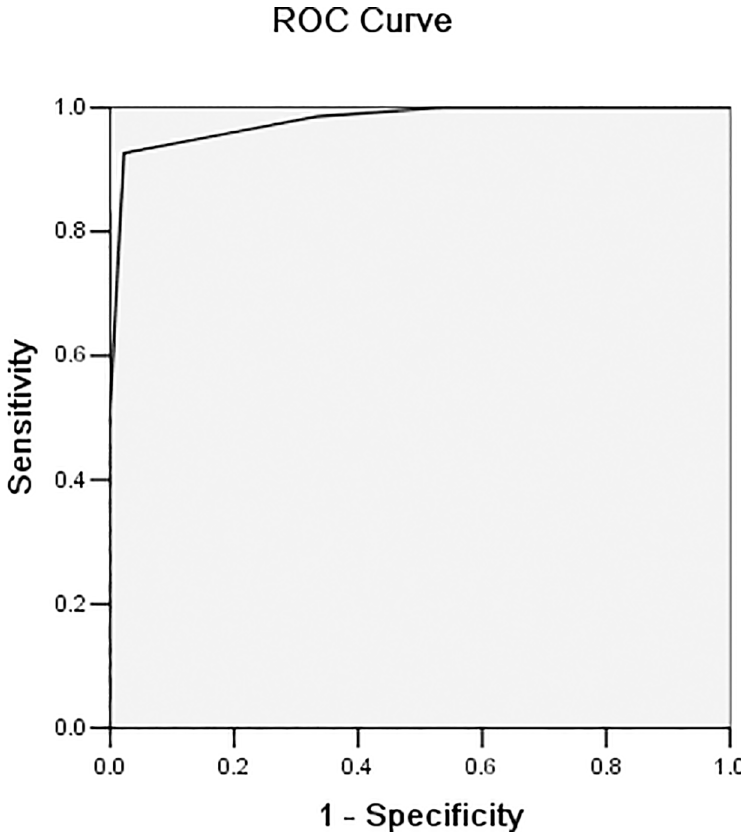
Fig 1. Predictive value of the STAF presented as ROC curve for the diagnosis of CE. The area under the ROC curve (AUC) was 0.929, which suggested good diagnostic value of the STAF for the diagnosis of CE.